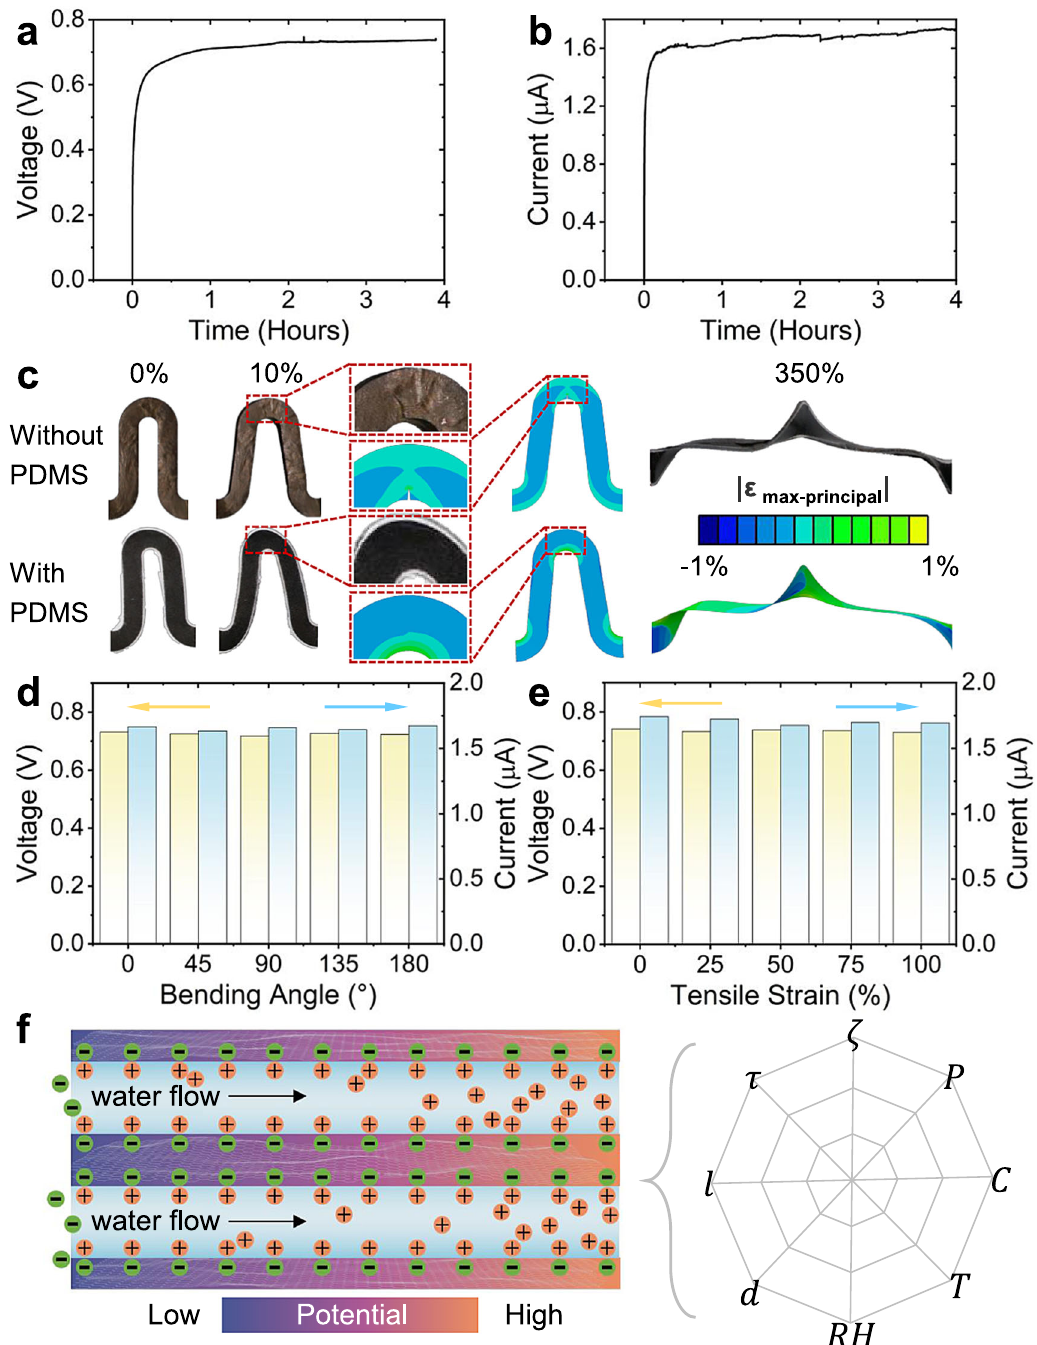
Fig. 3 | Electricoutput performance of2D-WEG.a V oc and b I sc of anas-prepared 2D-WEG. c Optical images and fi nite-element analysis results of serpentine- structured GO assembled frameworks with and without PDMS coating, which was stretched by 0% (initial state), 10%, and 350%. The locally enlarged views of fi nite- element analysis results and optical photos show that the GO-assembled frame- workwithoutPDMScoatinghasobviousdamageduetostressconcentrationunder 10%tensiledeformation, while the GO-assembledframeworkwithPDMScoating is not damaged by stress concentration. Meanwhile, the maximum strain is still less thanthecriticalstrainatabreakunder350%tensiledeformation. V oc outputand I sc